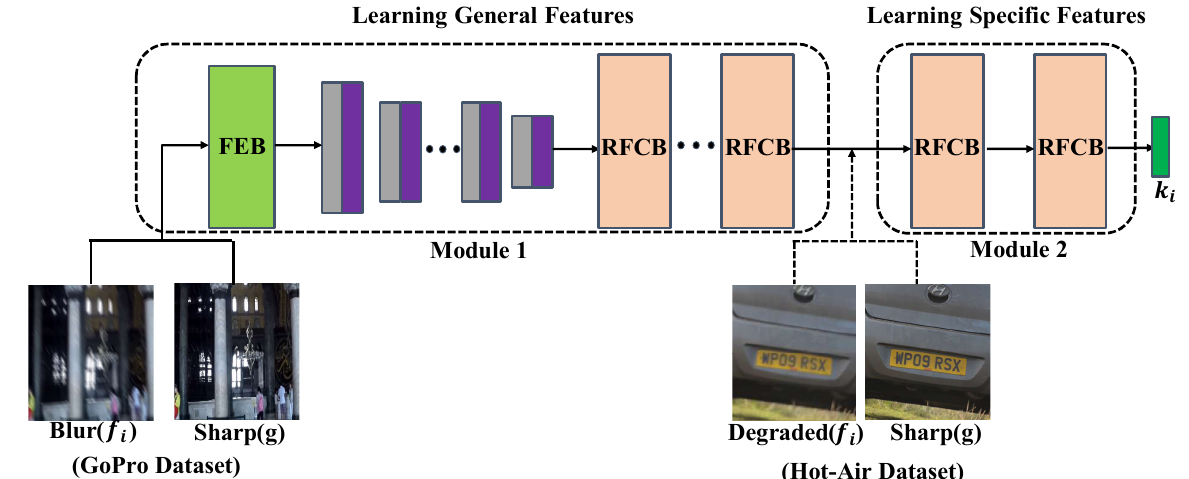
Figure 4. Block diagram of Network D1 (training processing).